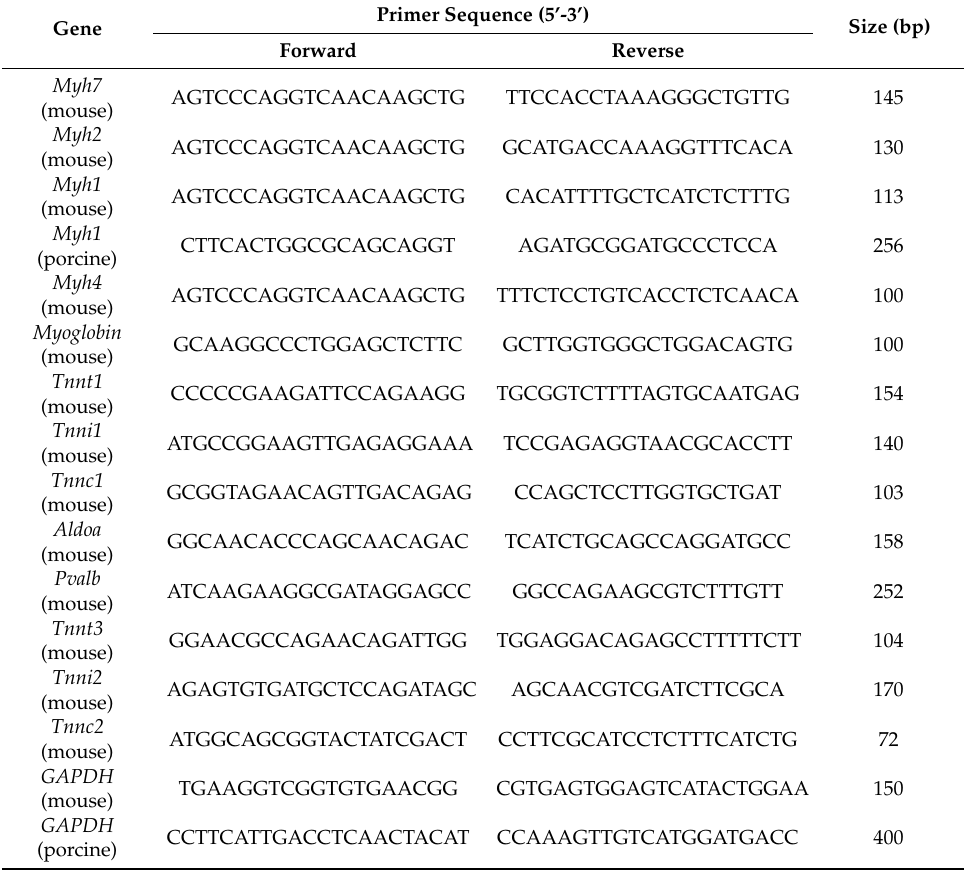
Table 1. List of primer